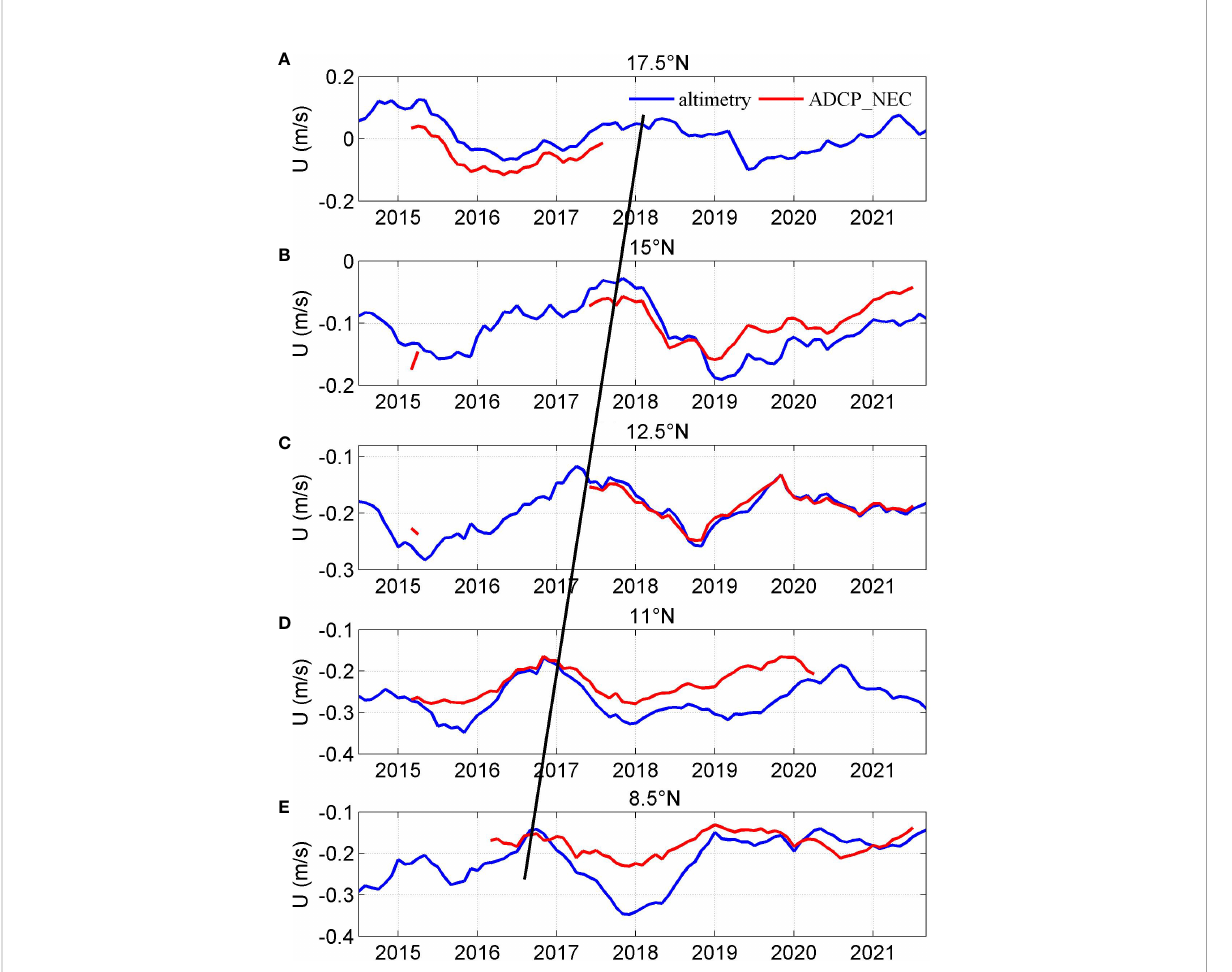
FIGURE 5 Vertically averaged zonal velocity (m/s) between 50-100 m derived from mooring ADCP measurements (red) at (A) 17.5°N, (B) 15°N, (C) 12.5°N, (D) 11°N and (E) 8.5°N during 2014-2021, compared with the zonal geostrophic velocity (m/s) at the same locations derived from satellite altimetry (blue). All the time series have been smoothed with a 1-year low-pass fi